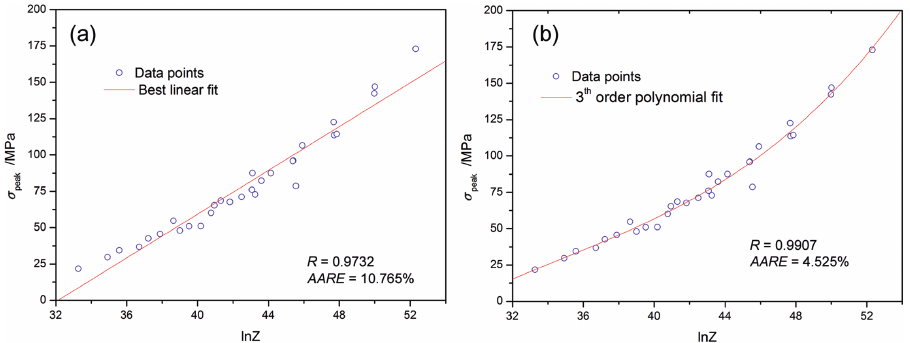
Figure 7: Relationship between σ peak and the lnZ: (a) linear fitting and (b) polynomial